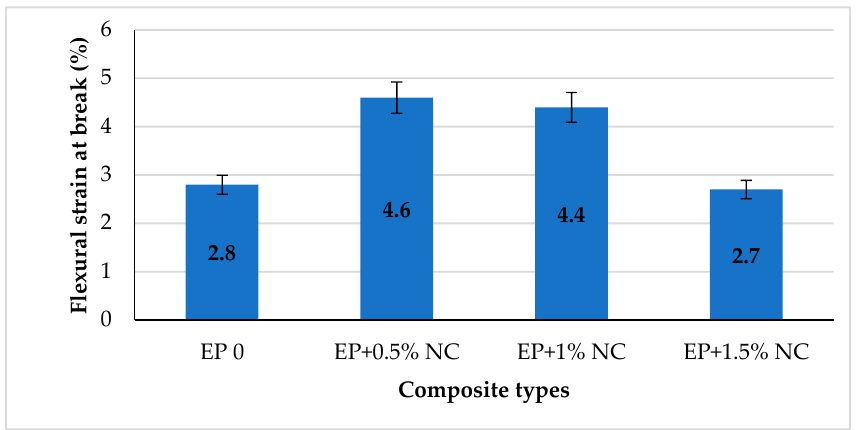
Figure 8. Flexural strain at break for epoxy composites with NC. Based on the values shown in the graph it was shown that a small addition of cellulose nanofiller contributes to an increase of the flexural strain at break. A maximum increase of about 64% was observed for 0.5% NC in comparison with EP 0. Then, a slight decrease in strain value was observed for composite with 1% on NC and rapid drop-down for EP + 1.5% NC. This might be attributed to the larger amount of well-dispersed cellulose nanoparticles within the epoxy matrix, as well as the formation of strong interaction between EP and NC [29,47]. This is also confirmed by the flexural modulus values shown in Figure 9.